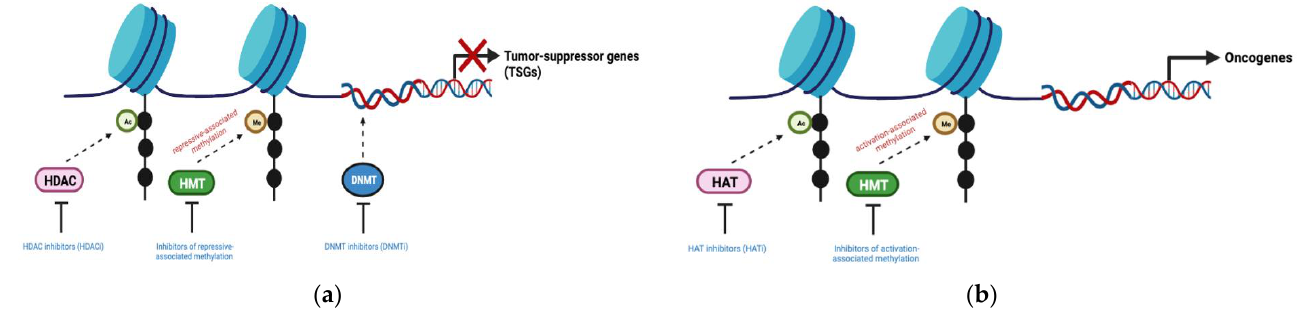
Figure 3. Aberrant epigenetic mechanisms in cancer and the specific application of epigenetic modifier inhibitors to reverse its effects. ( a ) Tumor suppressor silencing observed in cancers can be induced by DNA methylation (with DNMTs), histone deacetylation (with HDACs), or repressive histone methylation (with HMTs); ( b ) Oncogene activation observed in cancers can be induced by activation-associated histone hypermethylation (with HMTs) or histone hyperacetylation (with HATs). DNMT (DNA methyltransferase); HMT (Histone methyltransferase); HDAC (Histone deacetylase); HAT (Histone acetyltransferase). Figure created with BioRender.com (accessed on 30 December 2022).